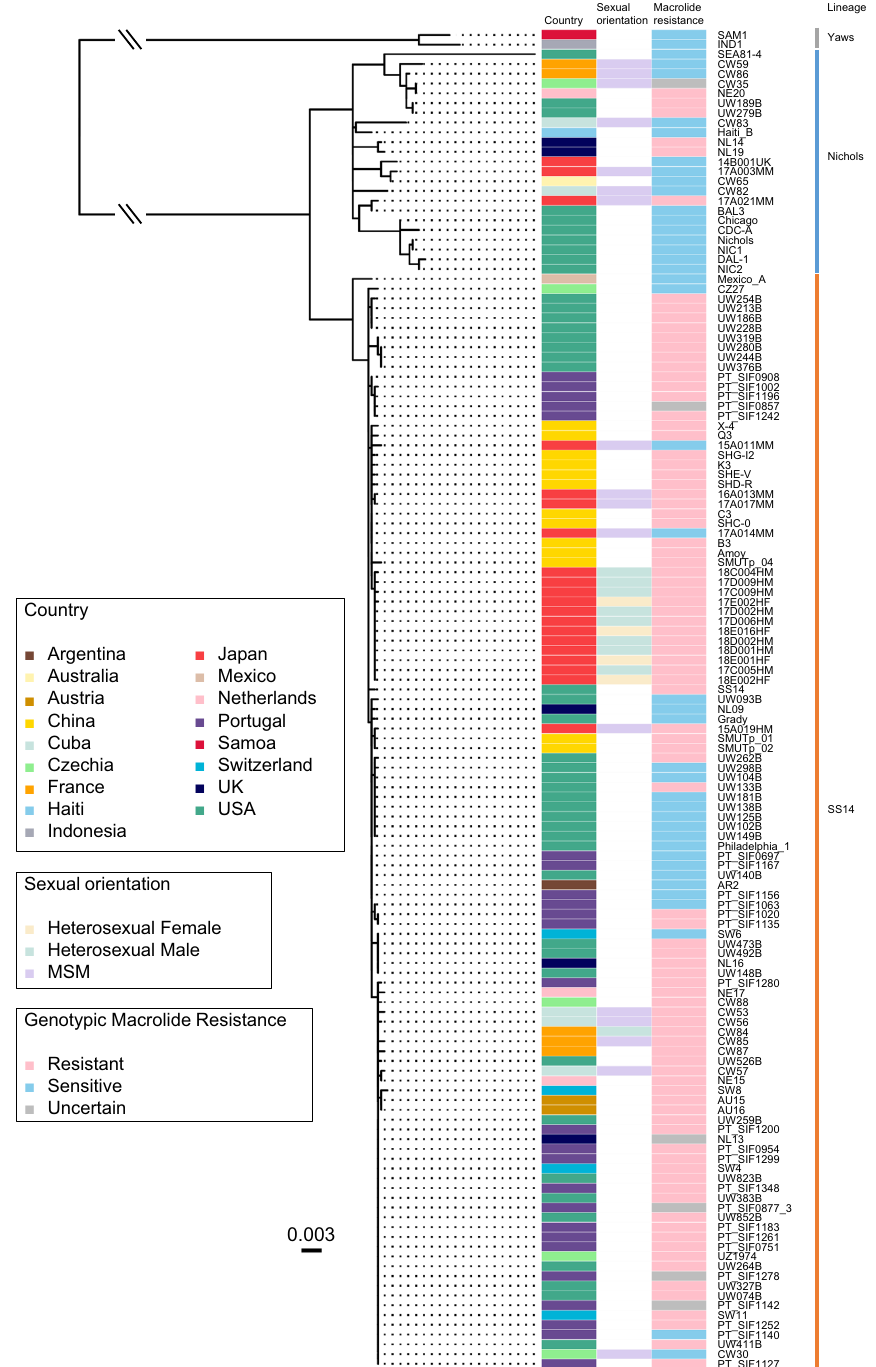
Figure 1. Maximum likelihood phylogenetic analysis of 135 Treponema pallidum subspecies pallidum and 2 Treponema pallidum subspecies pertenue genomes. The boxes in the columns show (from the left) for each strain: its lineage, its country of origin, sexual orientation of the patient, and its macrolide resistance genetic profile. For macrolide resistance, if either the A2058G or A2059G mutation in the 23S rRNA genes was present, the strain was classified as resistant. If mixed alleles were detected in these sites, the strain was classified as ‘‘uncertain’’. The scale represents the number of substitutions per